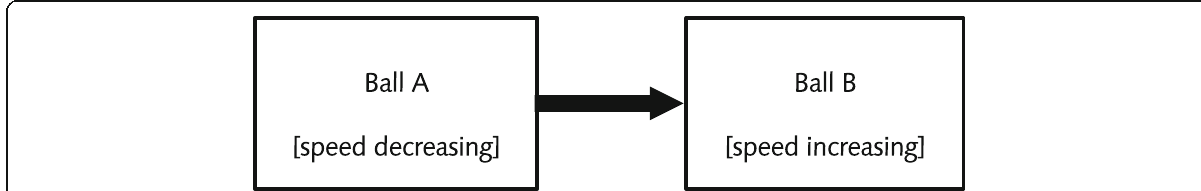
Fig. 2 ETM fort wo balls A and B colliding. The boxes represent the systems, the arrow represents the direction of energy transfer, and the text in brackets describes the energy-related processes in the